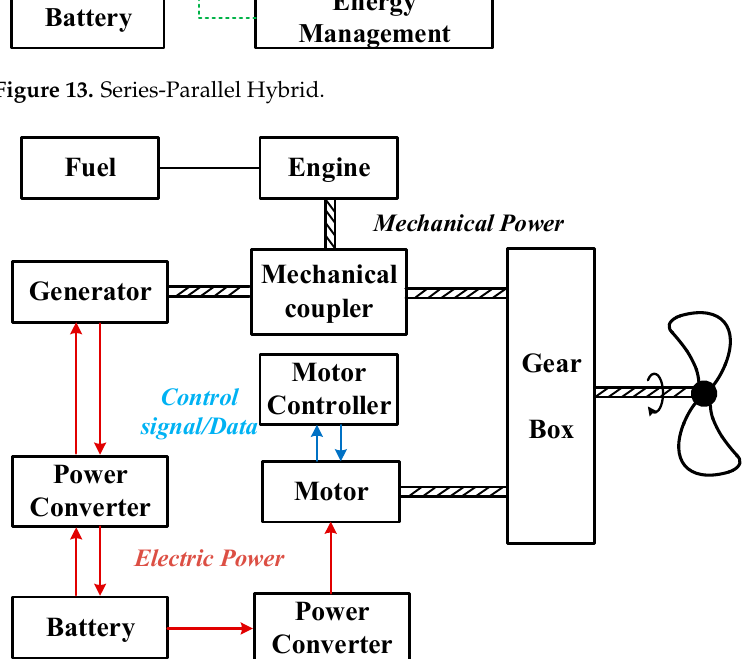
Figure 13. Series-Parallel Hybrid.